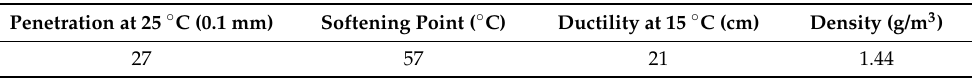
Table 4. The performances of aged asphalt binder extracted from reclaimed asphalt pavement (RAP).